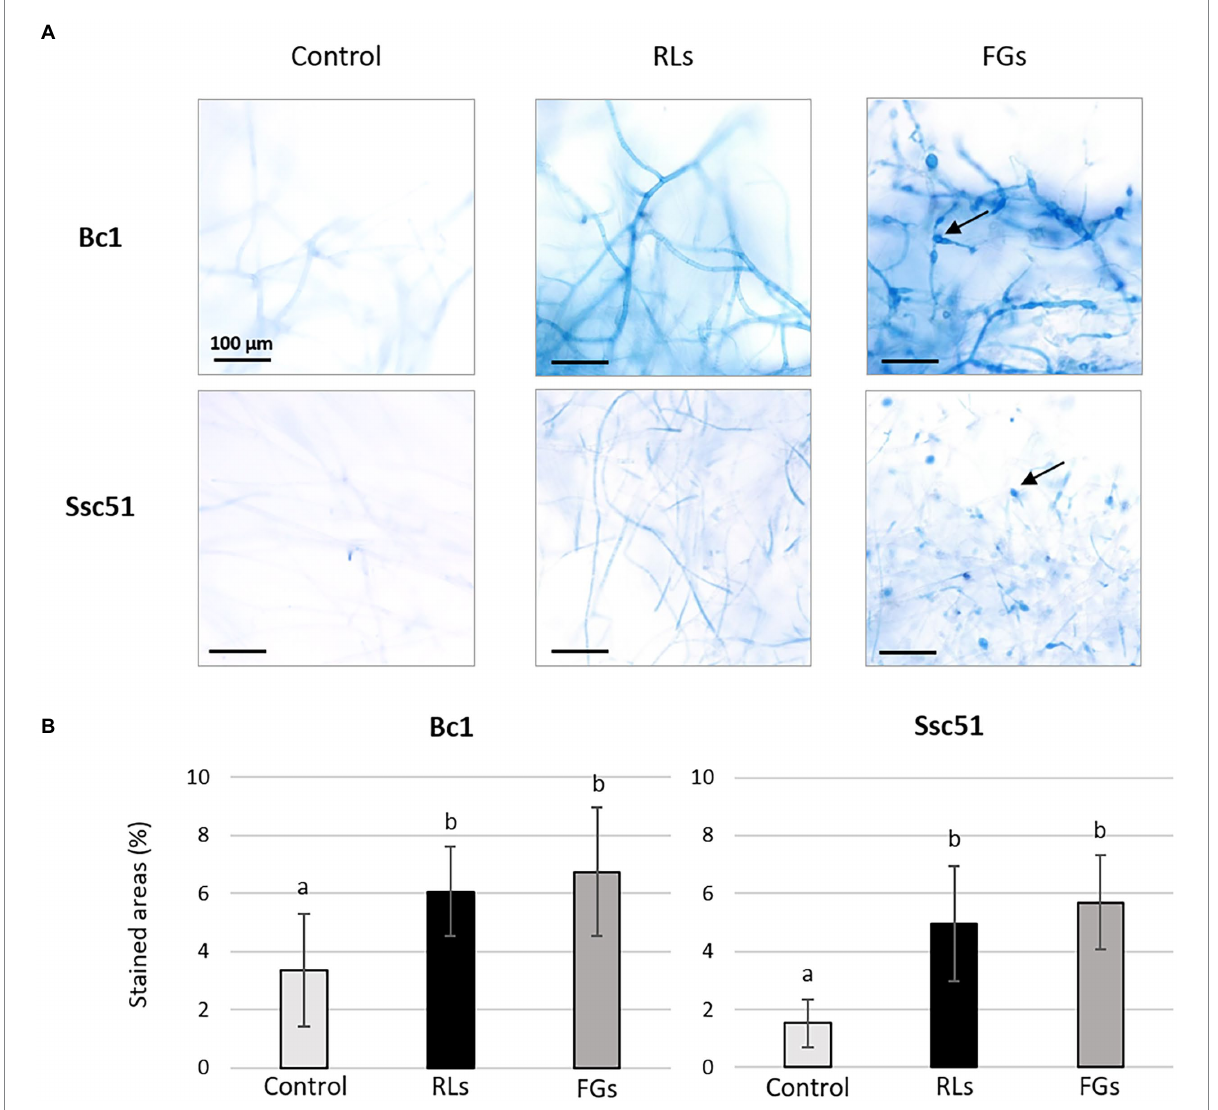
FIGURE 6 Evans blue dye coloration of Bc1 and Ssc51 mycelium after treatments with 25 μ g mL − 1 RLs or 50 μ g mL − 1 FGs. Light microscopy observations of stained mycelia, the arrows indicate vesicle-like structures. Scale bar: 100 μ m (A) . Quantification of stained areas (%). Error bars represent standard errors. Letters indicate significant differences ( p < 0.05) between the groups (B)